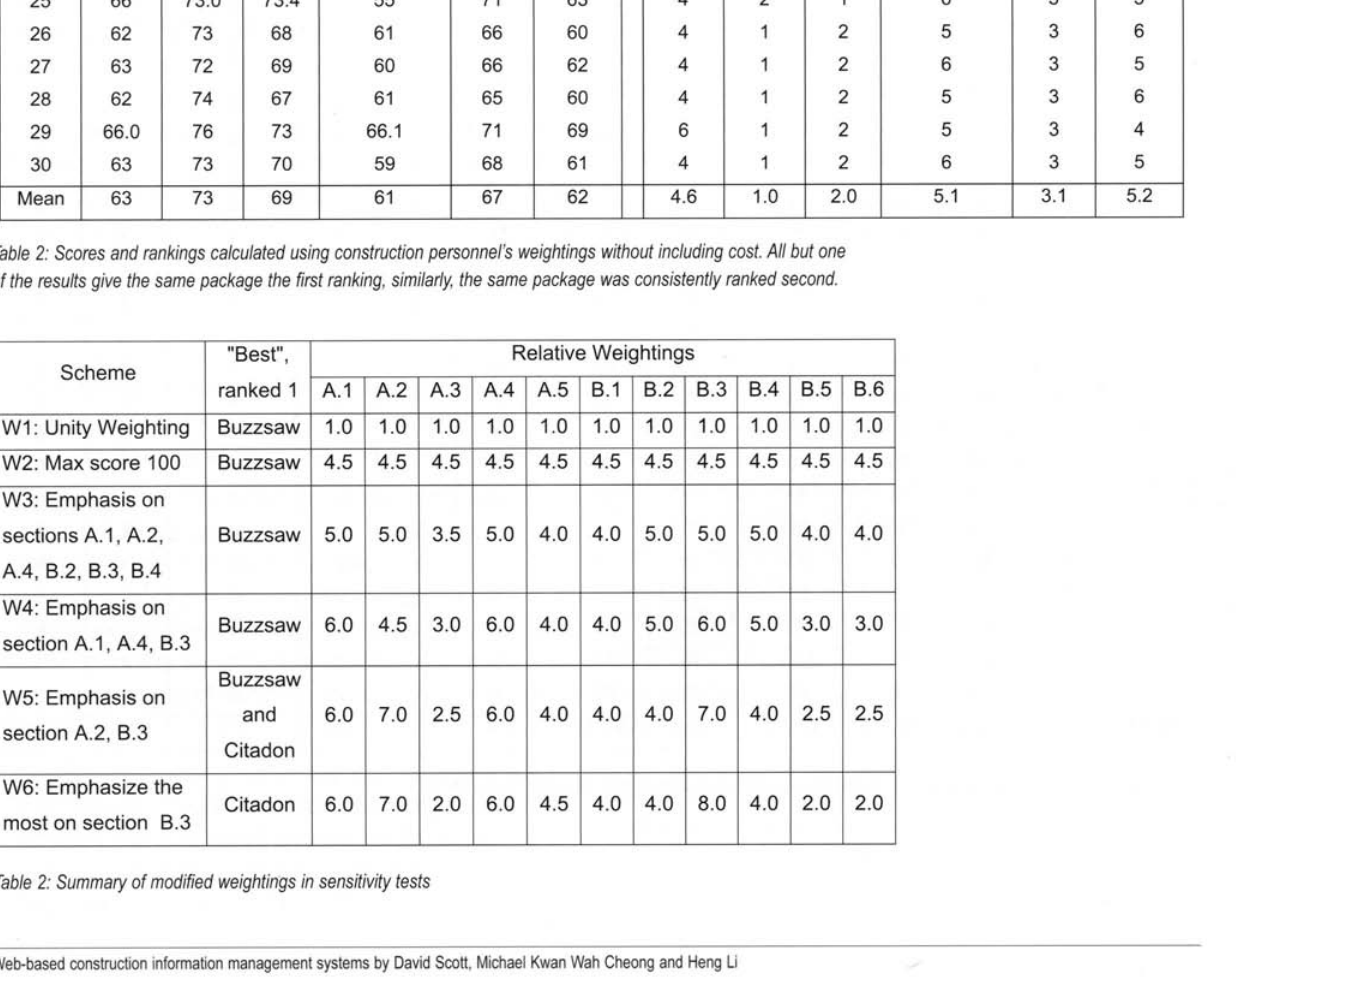
Table 2: Summary of modified weightings in sensitivity